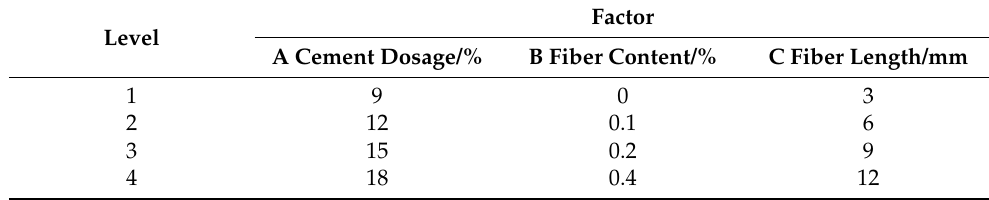
Table 3. Factors and levels of orthogonal test.